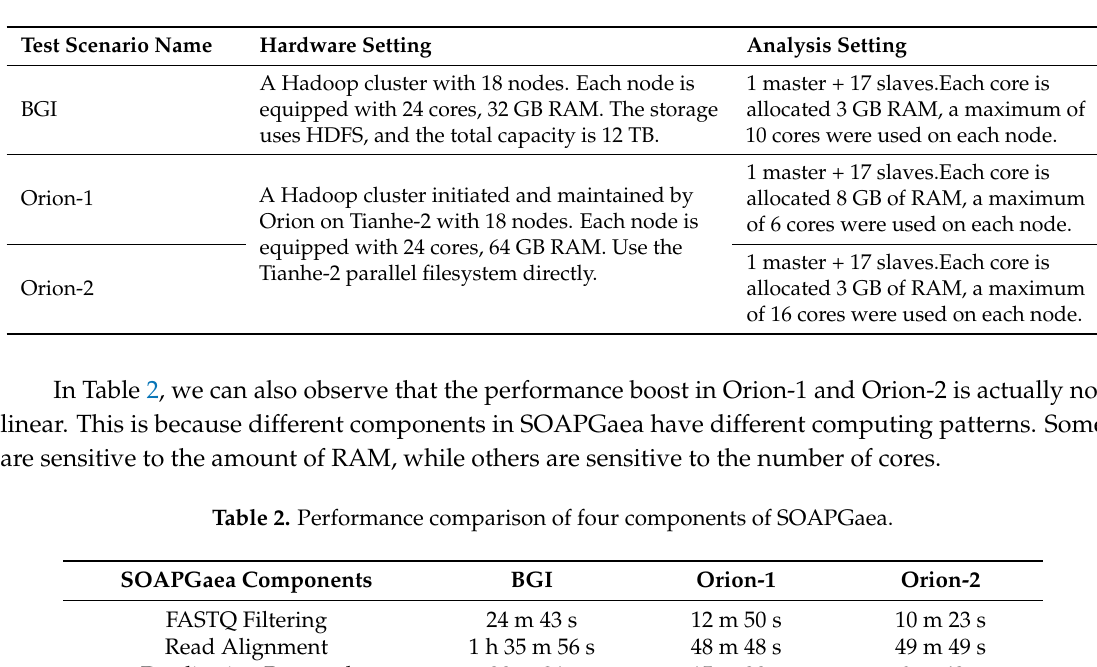
Table 1. Hardware and software settings of the Hadoop test. BGI: Beijing Genomics Institute; HDFS: Hadoop Distributed File System.